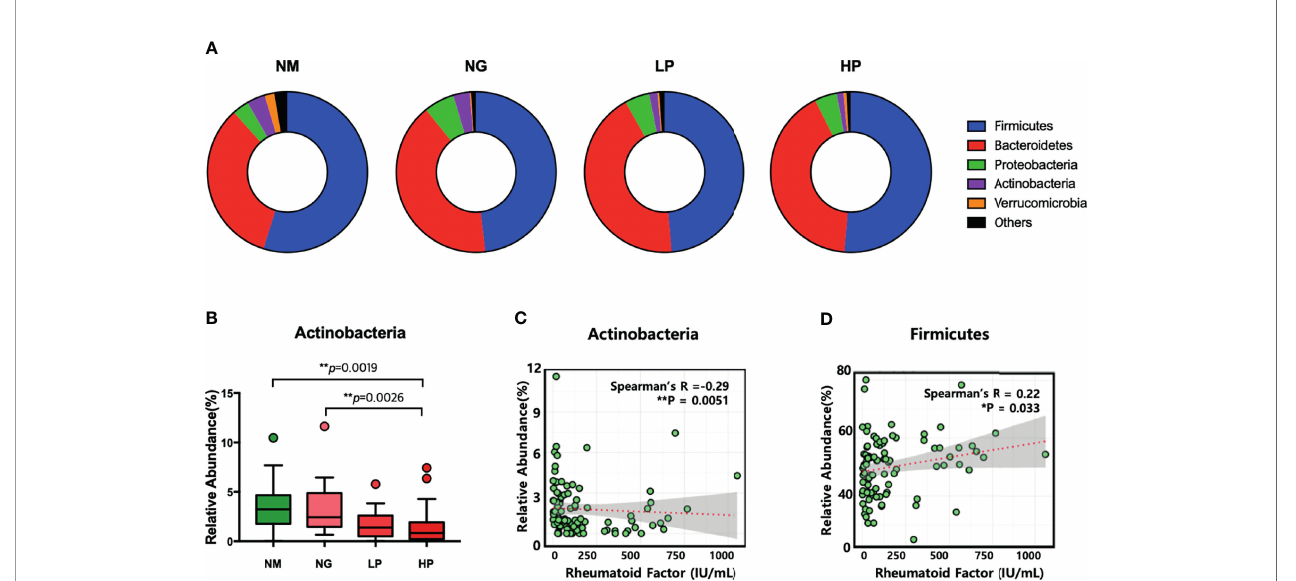
FIGURE 1 | Microbial composition at the phylum level in patients with different rheumatoid factor (RF) levels. (A) Comparison of intestinal micro fl ora composition at the phylum level. (B) Relative abundance of Actinobacteria. Comparisons in relative abundance were performed using the Kruskal – Wallis test. (C) Correlation between the relative abundance of Actinobacteria and RF levels. (D) Correlation between the relative abundance of Firmicutes and RF levels. * p < 0.05; ** p < 0.01. NM, normal control; NG, rheumatoid arthritis (RA) patients showing 20 or less of RF level; LP, RA patients showing over 20 and not exceeding 60 of RF level; HP, RA patients showing over 60 of RF